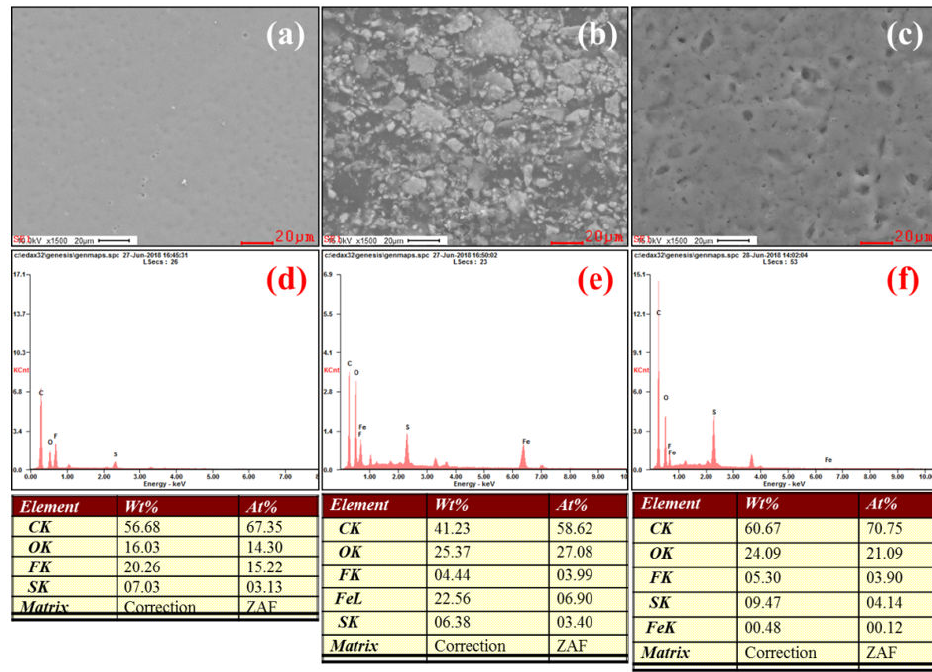
Figure 6. FE-SEM images and energy dispersive X-ray (EDX) spectra of membranes of ( a , d ) XY, ( b , e )